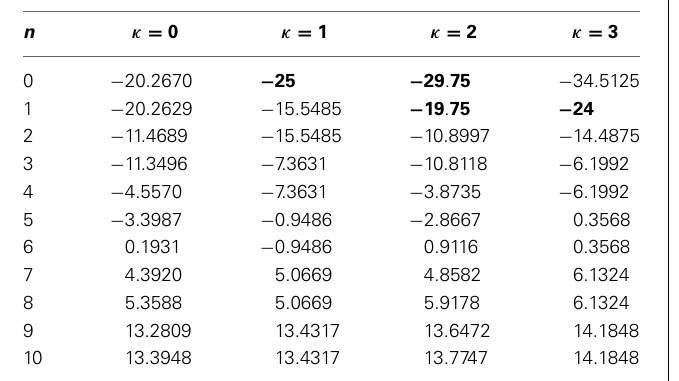
FIGURE 4 | Eigenenergies of a planar rotor subject to the combined orienting and aligning interactions as a function of η for a fixed ζ = 25. The dotted lines indicate (from bottom to top), respectively, the global minimum at − ( ζ + η ), the local/secondary minimum at − ( ζ − η ), and the maximum at η 2 4 ζ . Also shown are the values of the index κ which defines the loci of the intersections. For κ even, the intersections are avoided, for κ odd they are genuine. The red circles indicate the four cases for which analytic solutions have been found via SUSY, see section